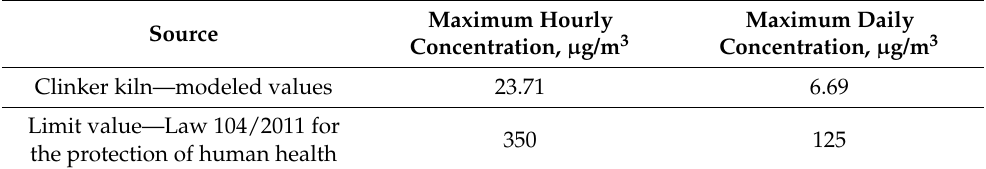
with the limit value provided in Law 104/2011, according to Table 10. For SO 2 , the maximum modeled concentrations (hourly and daily) are shown in Table 11 and Figures 18 and 19.